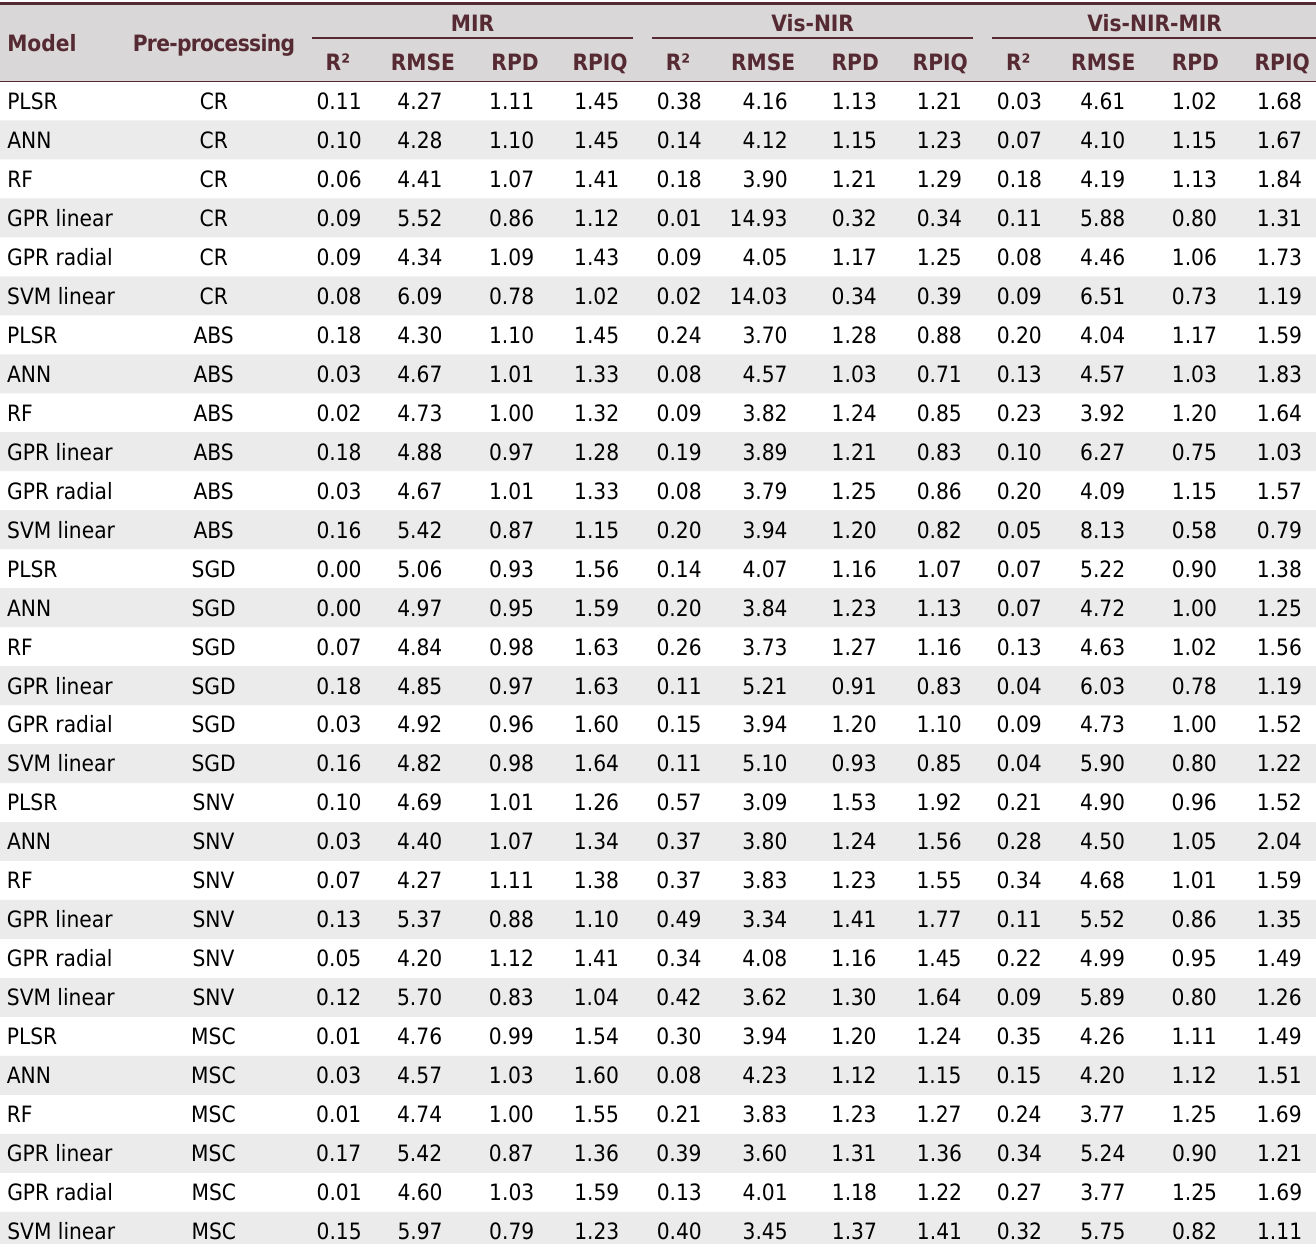
Table 4. Values of R 2 , RMSE, RPD, and RPIQ for the phosphorus property found for the different models and preprocessing methods in the MIR, Vis-NIR, and Vis-NIR-MIR spectra